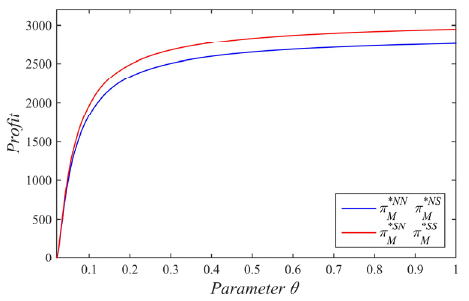
Figure 9. The impact of parameter β on the profits of manufacturer.